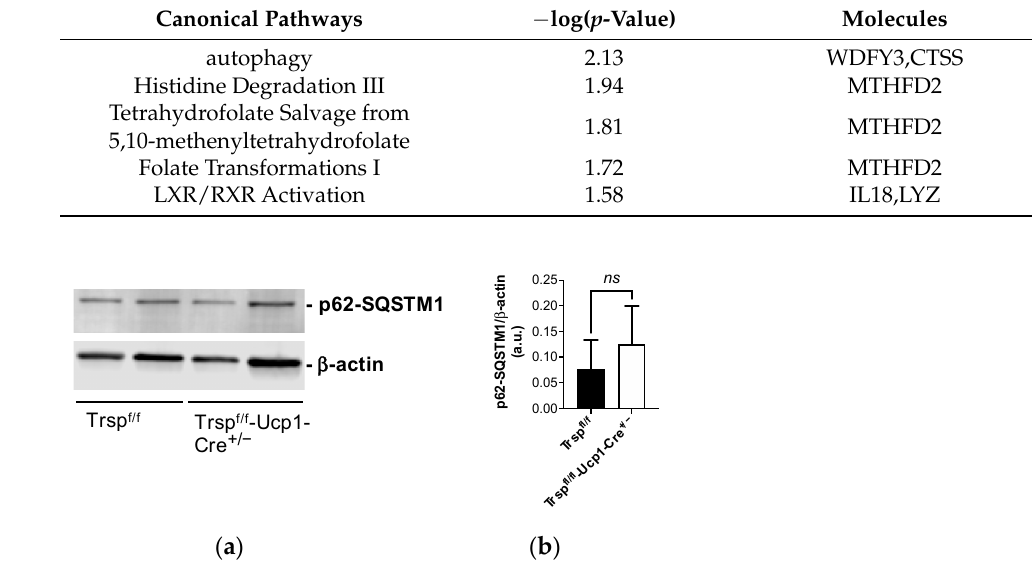
interaction = 0.59